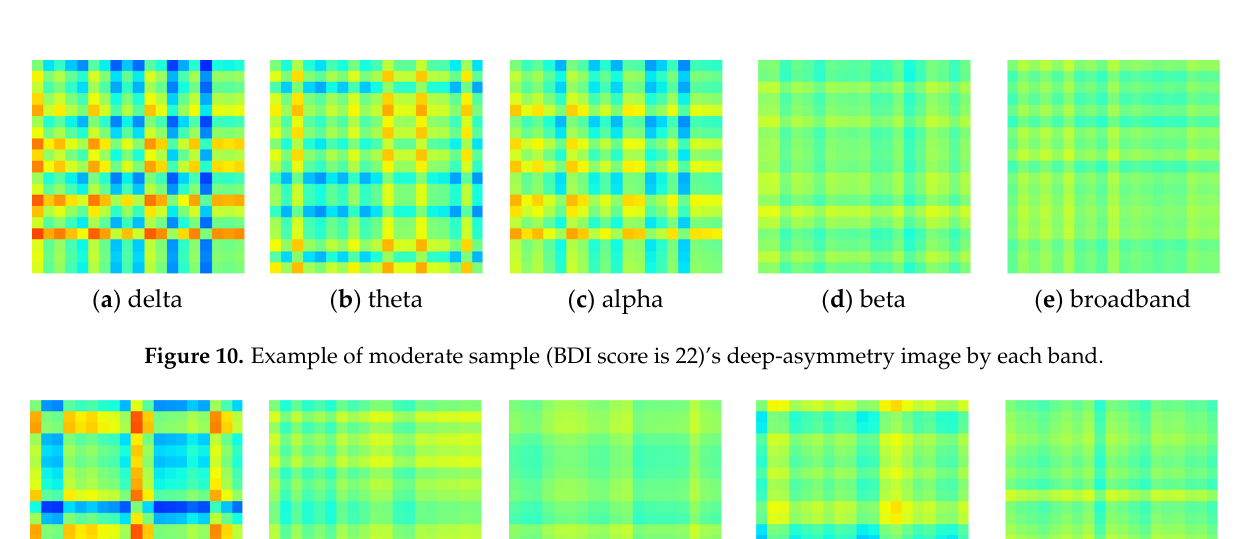
Figure 9. Example of mild sample (BDI score is 14)’s deep-asymmetry image by each band.